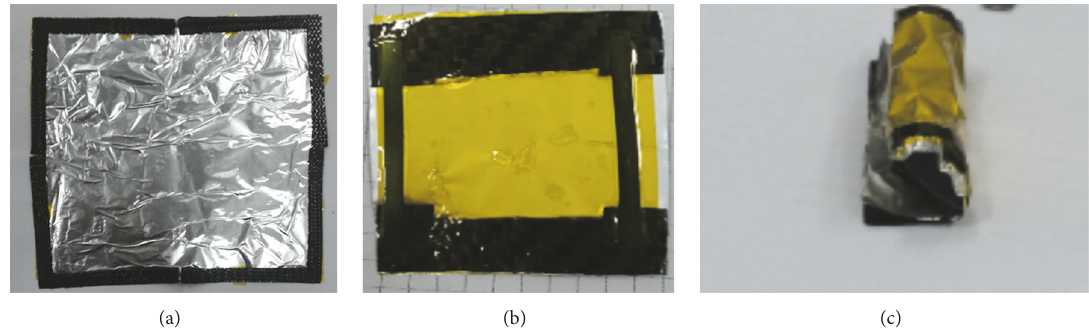
Figure 4: From (a) to (c) a 20 × 20cm 2 small-scale solar sail without Kapton, the configuration of solar sail without loom in one direction and its cylindrical bending.